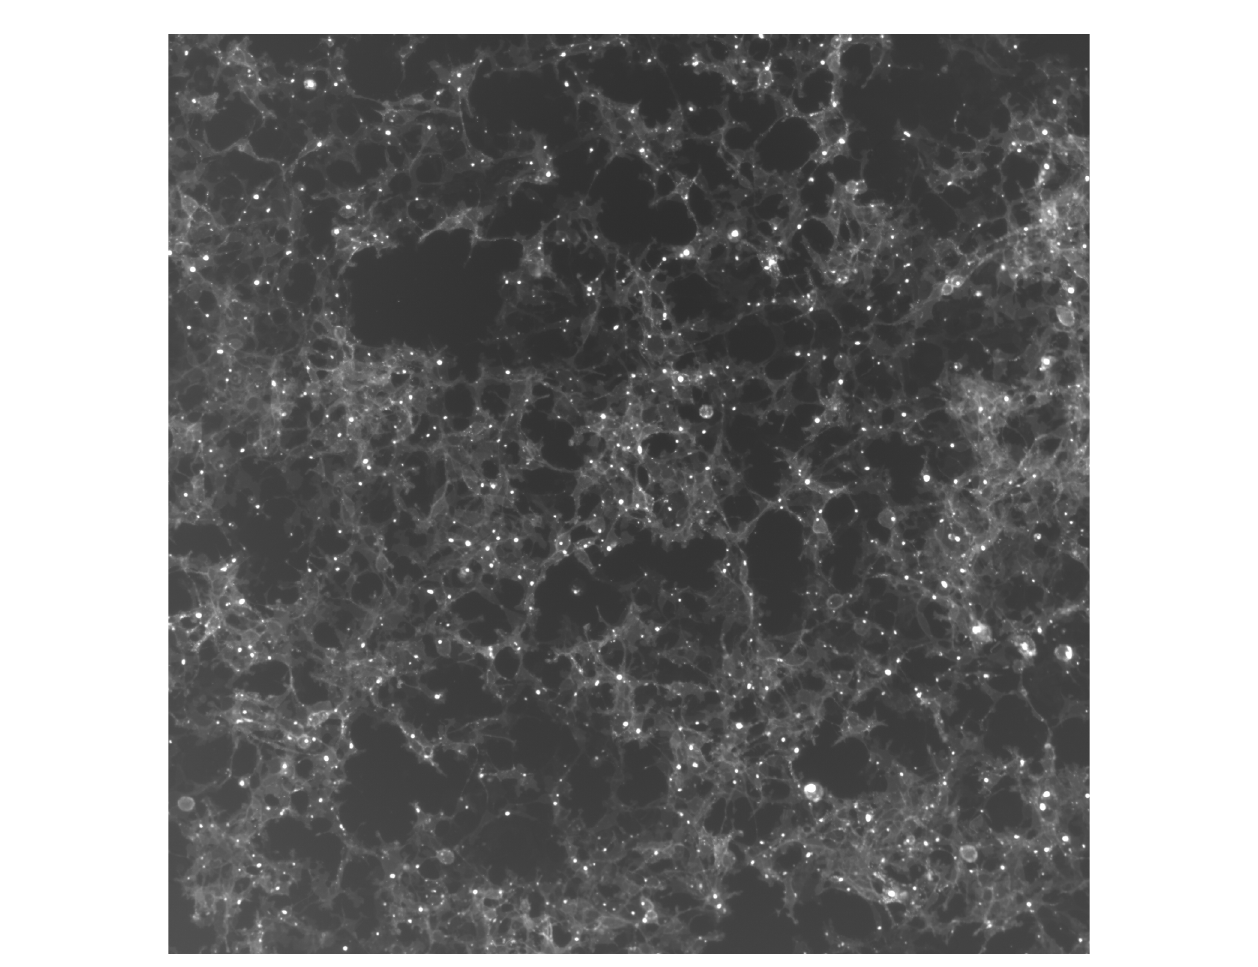
FIGURE 1 | Fluorescence image of HEK293T cells in culture. The clear areas indicate a high concentration of exosomes. These cells were engineered to produce exosomes containing the GFP fl uorescent